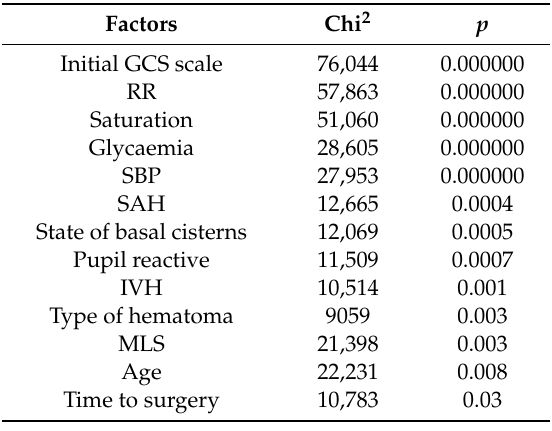
Table 3. Dominant factors for the dependent variables of the outcome.